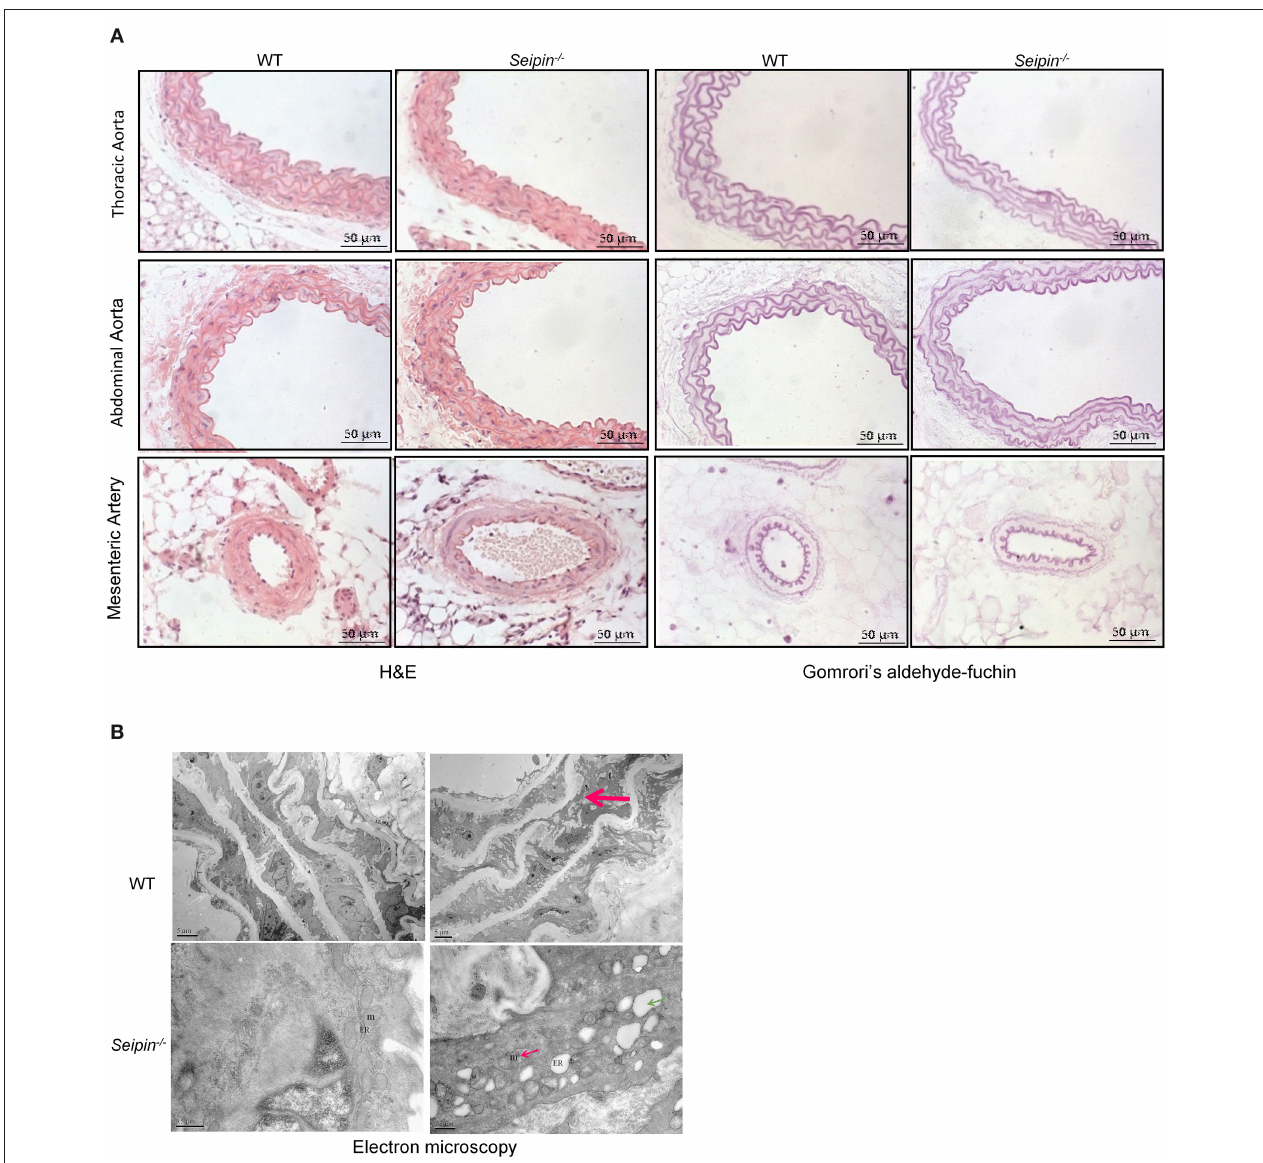
FIGURE 5 | Vascular lesion in aorta of Seipin − / − mice. (A) Representative H&E and Gomrori’s aldehyde-fuchin staining in thoracic aorta, abdominal aorta and mesenteric artery in WT and Seipin − / − mice. (B) Electron microscopy of thoracic aorta from 6-month-old Seipin − / − and WT mice. Red arrow indicated derangement of elastic fibers in aorta. Thin red arrow showed deformed mitochondria. Green arrow indicated dilated ER. m, mitochondria; ER, endoplasmic reticulum.